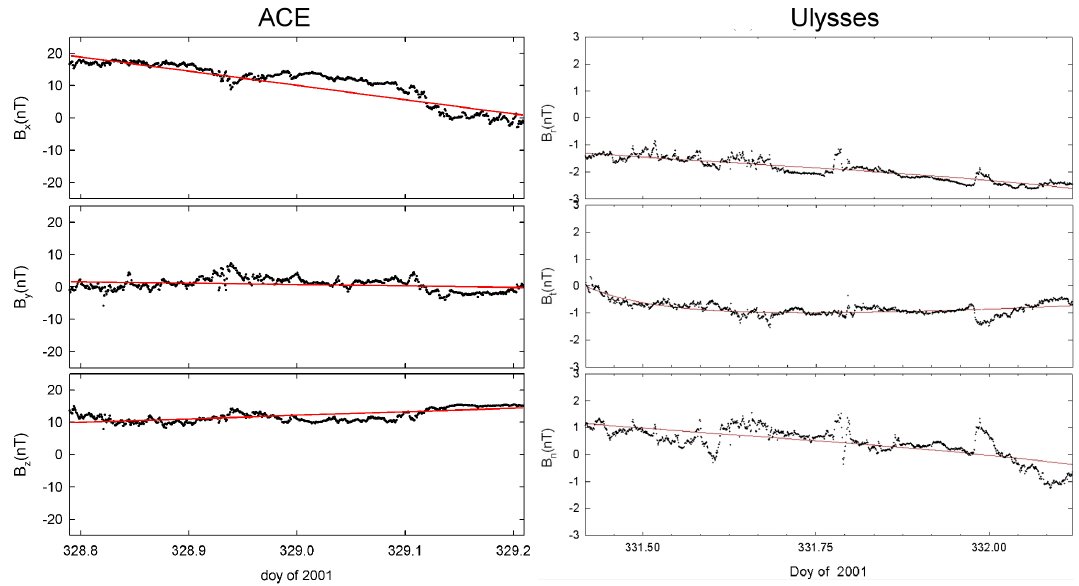
Fig. 7b. The three components of the magnetic field for the event of November 2001. The fit of the Hidalgo et al. (2002b) model is overplotted in red. Left panel shows ACE data and the right one the corresponding Ulysses data.